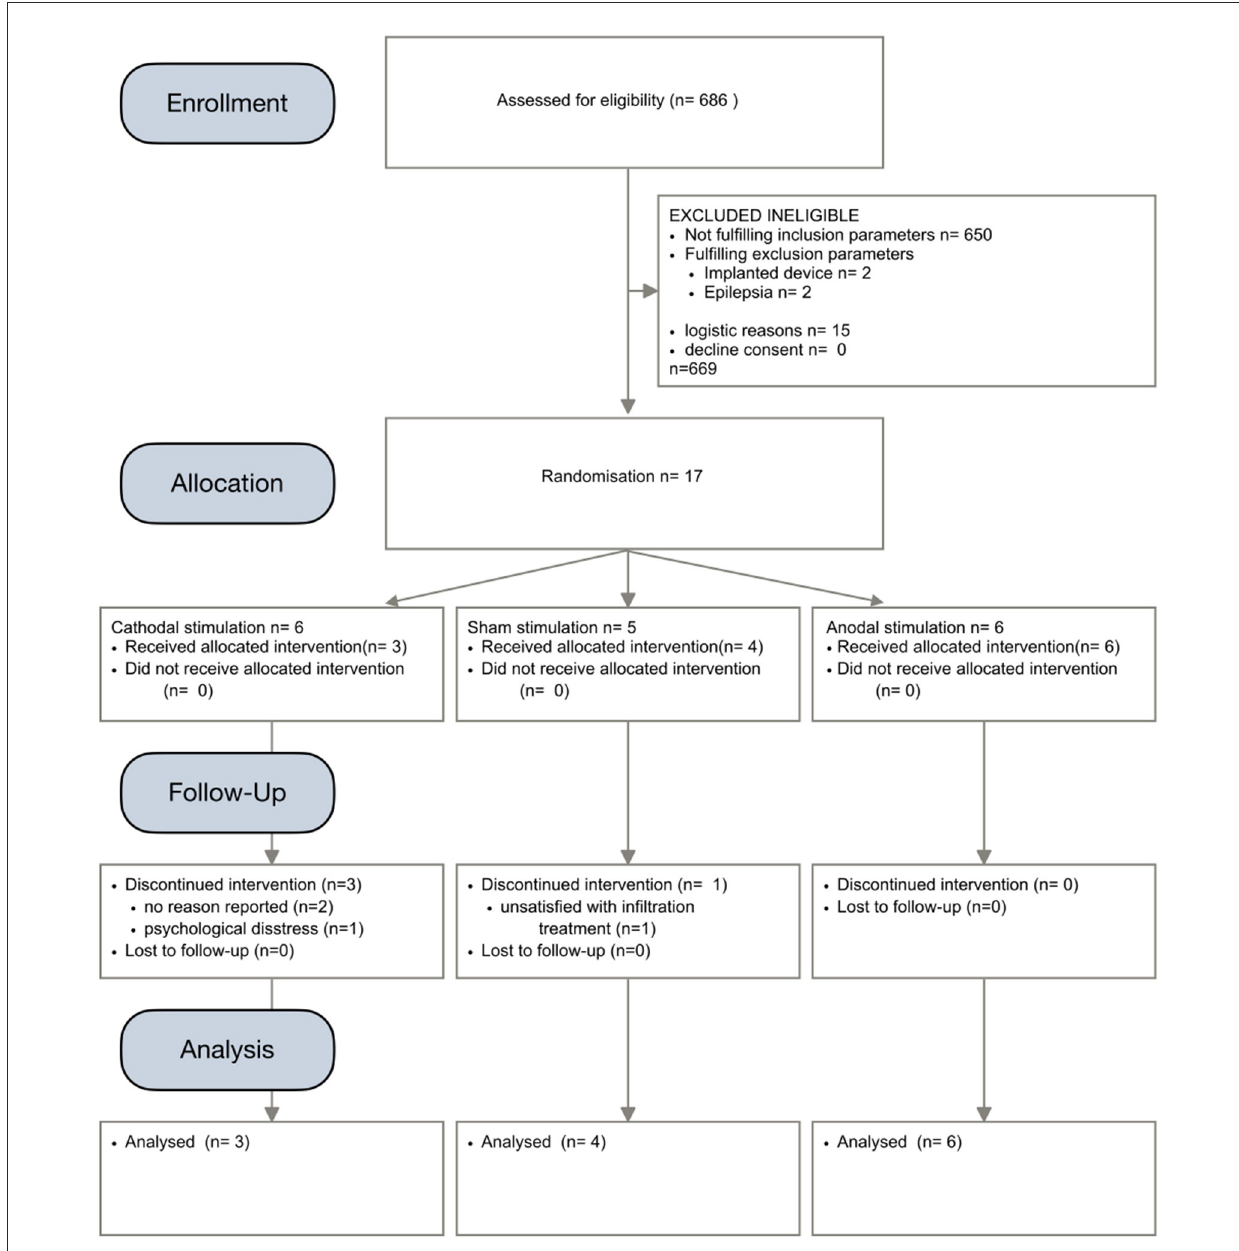
FIGURE1 CONSORT chart indicating process of patient recruitment for this study.